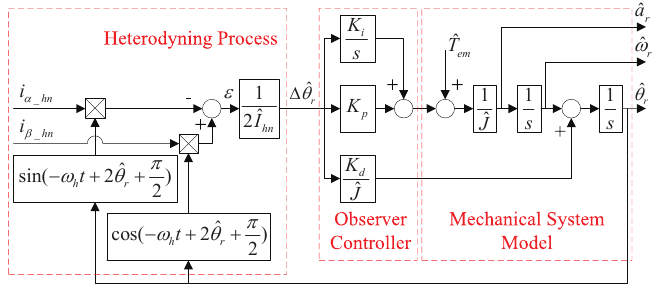
Figure 3. Luenberger-style motion observer with heterodyning for error